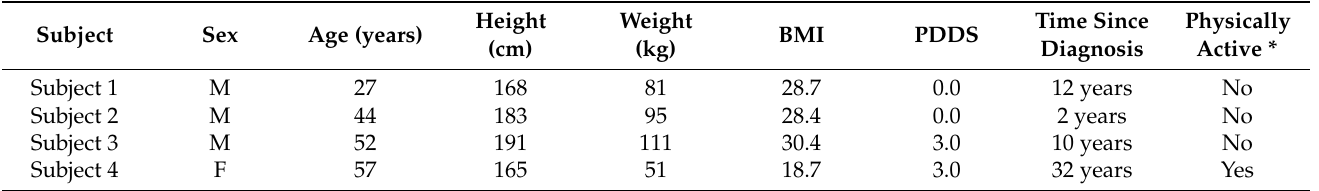
Table 1. Subject Characteristics.